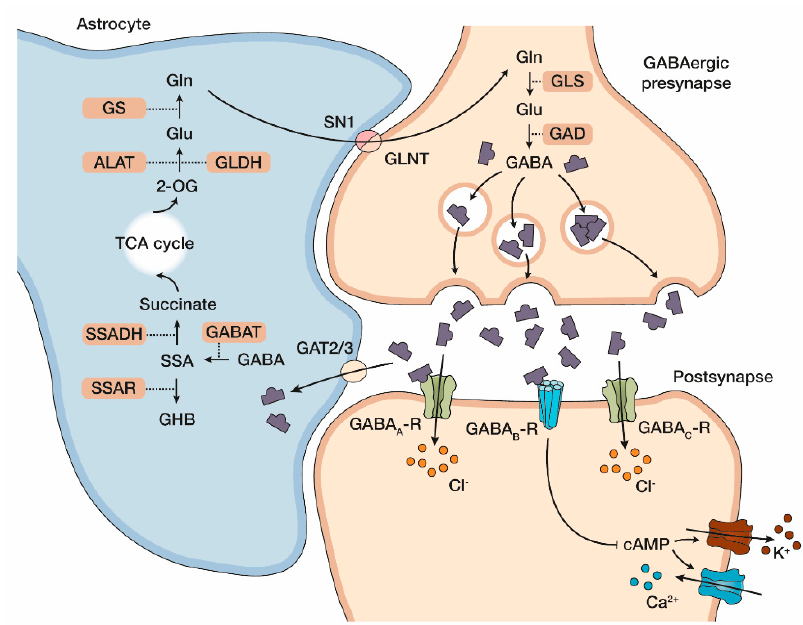
Figure 1. Overview of the synaptic cleft and the metabolic synopsis of a GABAergic synapse. The glutamate / GABA-glutamine cycle is depicted. GABA is synthesized in the presynaptic GABAergic synapse from glutamate (Glu) by glutamate decarboxylase (GAD) and is then packaged into vesicles. Upon electrophysiological activation, GABA is released into the synaptic cleft where it can bind to three known receptors. GABA A and GABA C receptors represent ionotropic receptors, whereas the GABA B receptor is G-protein coupled and functions via adenylate cyclase or by direct coupling with other ion channels. GABA neurotransmission is terminated after uptake of GABA by GABA transporter 2 / 3 (GAT 2 / 3) into astrocytes, where GABA transaminase (GABAT) converts it into succinic semialdehyde (SSA). SSA is then oxidized by SSADH to succinate and serves as a substrate within the tricarboxylic acid (TCA) cycle. α -ketoglutarate (2-OG) can be used for the synthesis of Glu by alanine transaminase (ALAT) and glutamate dehydrogenase (GLDH) and glutamine (Gln) by glutaminase (GS). Gln is then shuttled back to presynaptic GABAergic neurons via glutamine transporter SLC38A3 (SN1) and glutamine transporter SLC38A2 (GLNT). In SSADH-D, SSA cannot be converted to succinate but is reduced to GHB by SSA reductase (SSAR) (adapted from [15,16] ).